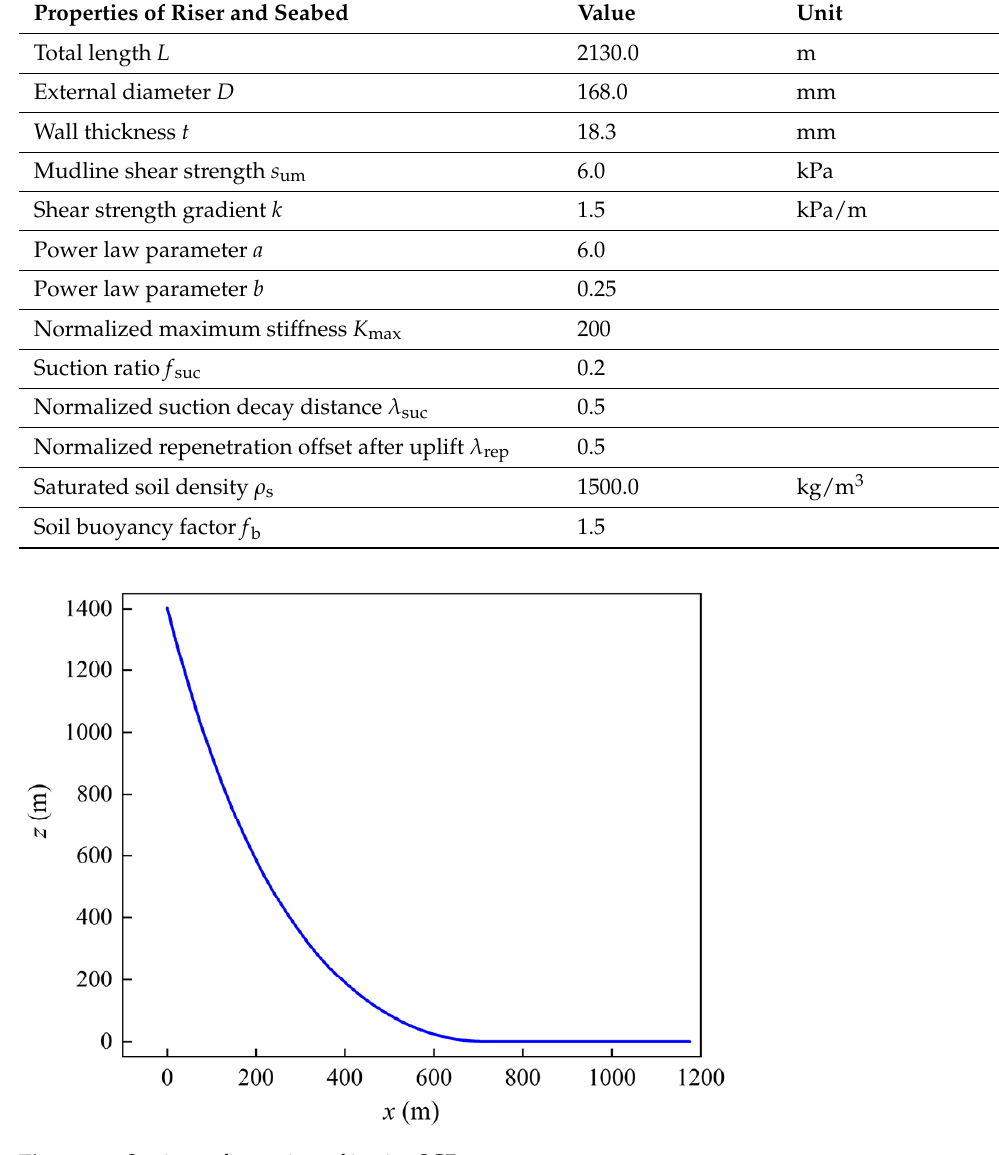
Figure 16. Distribution of bending moment.